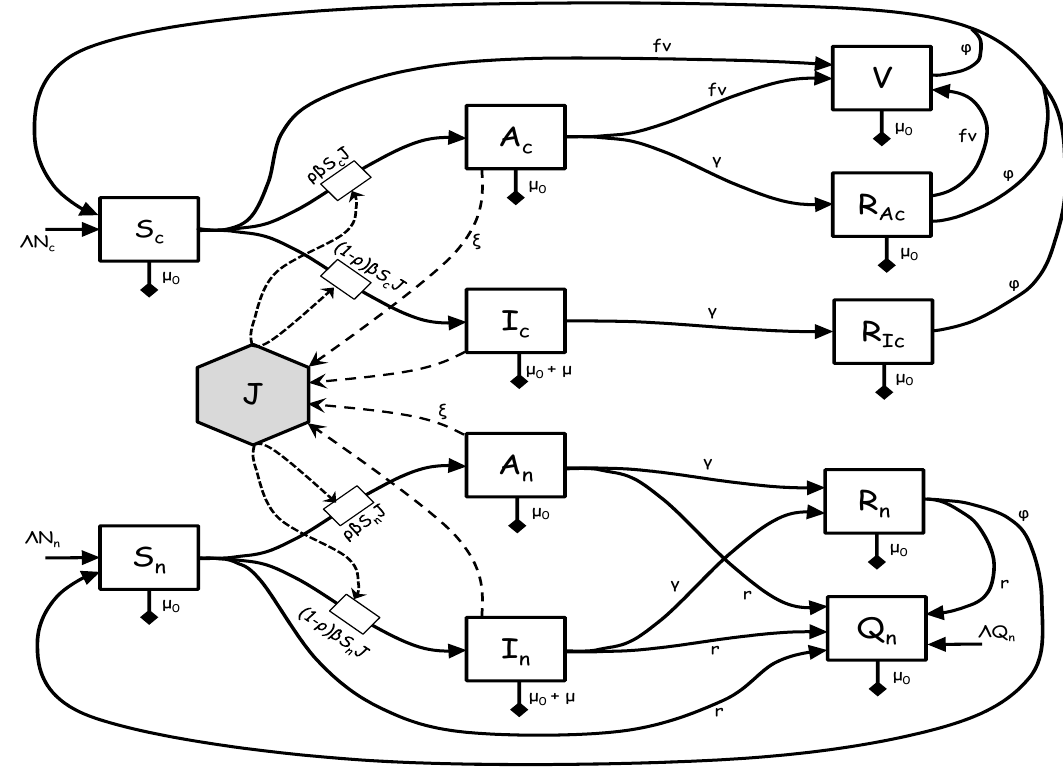
Figure 1. A compartmental model describing the movement of individuals from susceptible to infectious to recovered, with two infectious classes, symptomatic and asymptomatic; a transitional main population in which conditions improve over time and an intractable indigent core. Compartment J is the time-delayed effective infectious class that replaces explicit water bodies and bacterial compartments (see